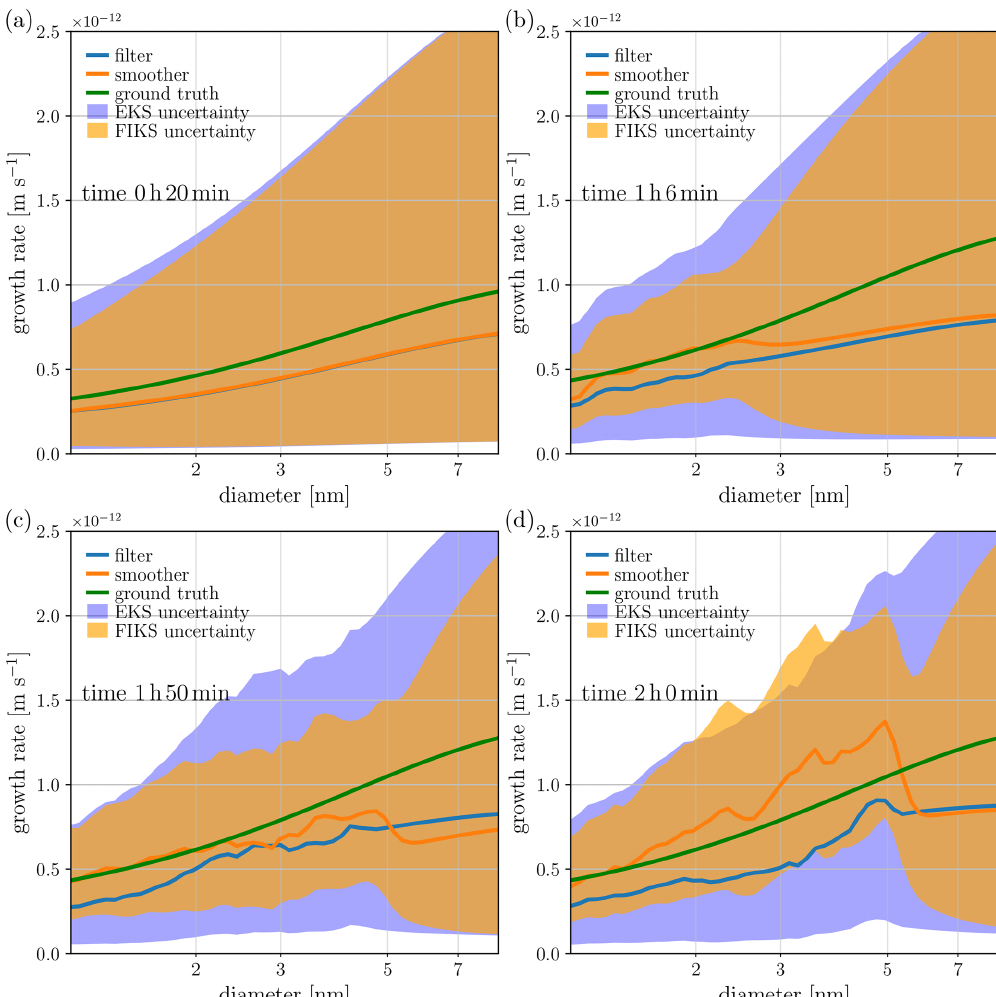
Figure 9. Case 4 – SS and low SNR. Condensational growth rate estimates corresponding to four instants in time. The blue and orange lines represent the approximate posterior expectations for EKF and FIKS, respectively, and the areas shaded with light blue and orange are the respective posterior error intervals. The true growth rates are marked with green